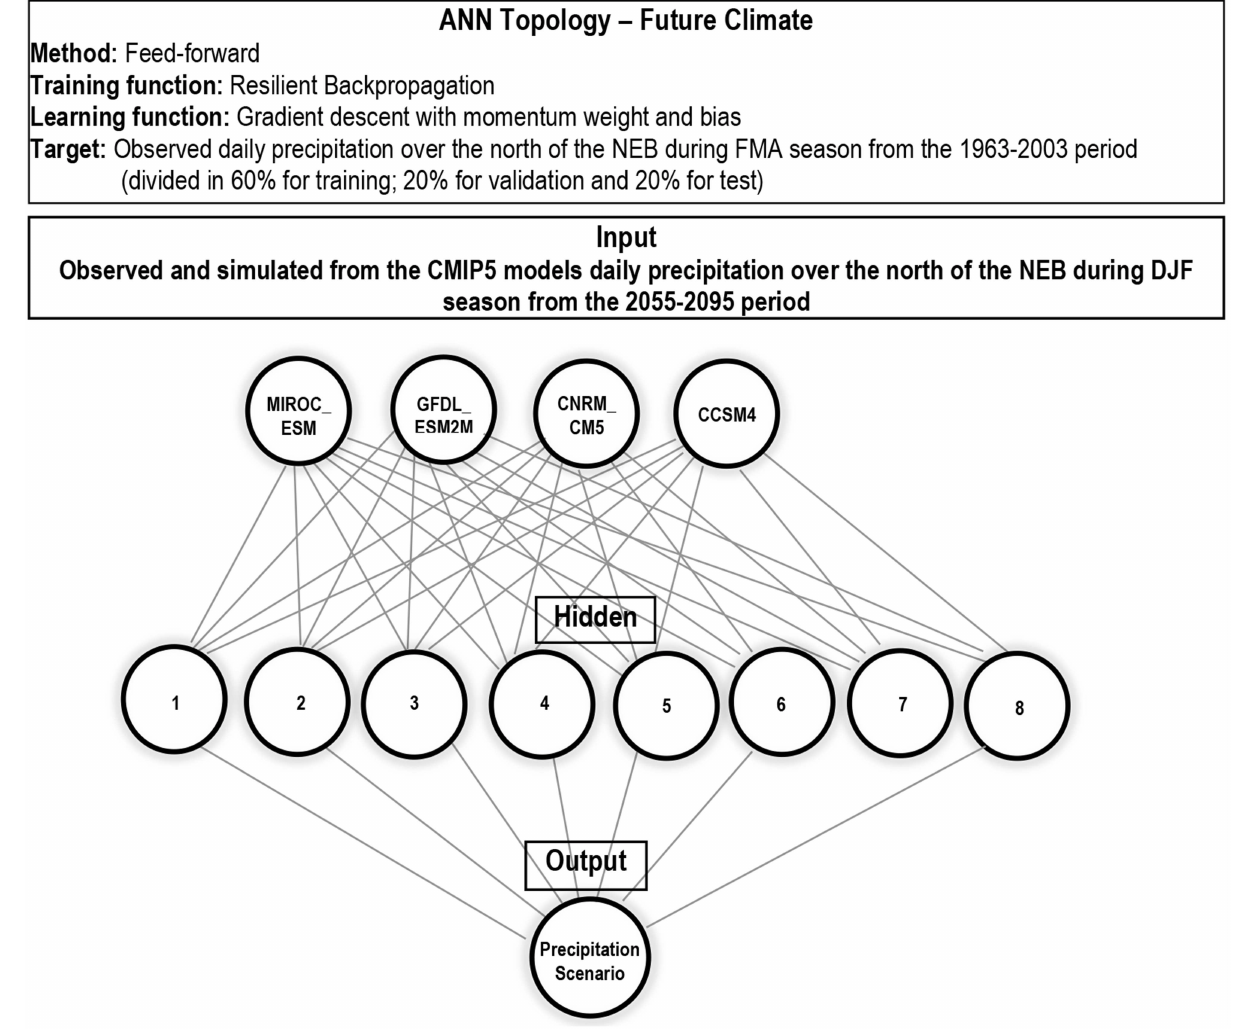
FIGURE 3 | ANN topology used for the future climate